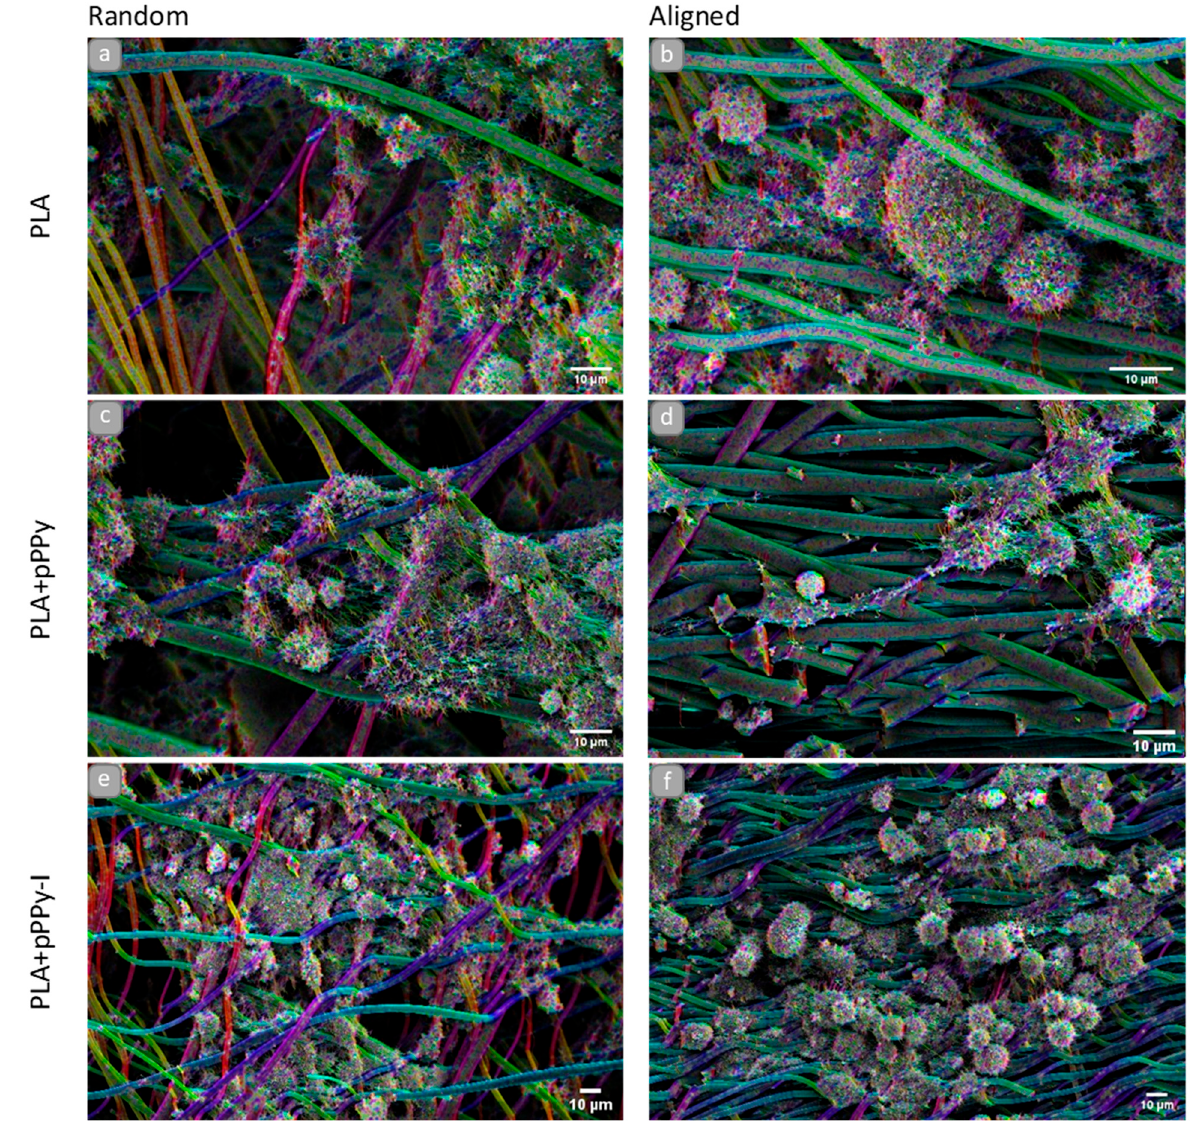
Figure 13. SEM images, color coded for directionality, of NG108 ‐ 15 cell line on the scaffolds, bar = 10 μ m. OrientationJ Fiji plugin, gaussian window σ = 0.7, min. Coherency = 2%, min. Energy = 2%. ( a ) rPLA, ( b ) aPLA, ( c ) rPLA+pPPy, ( d ) aPLA+pPPy, ( e ) rPLA+pPPy/I, ( f ) aPLA+pPPy/I.